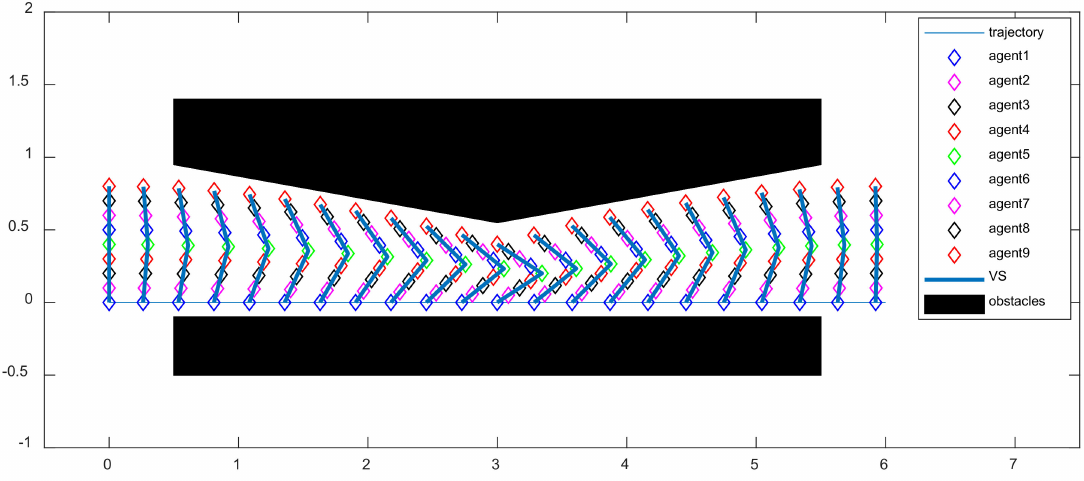
Figure 28. Formation reconfiguration using virtual structure approach.